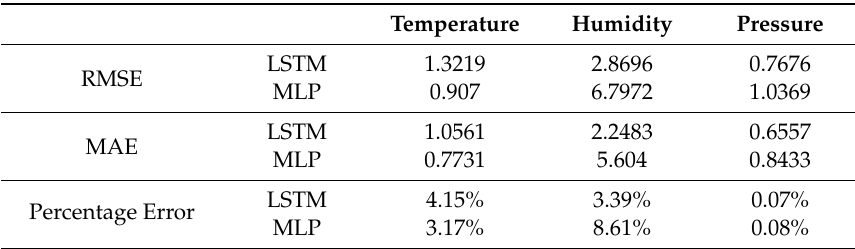
Figure 12. Forecast results of temperature, humidity, and pressure on 21 March 2020: LSTM model vs. MLP model. Table 10. Forecast performance on 21 March